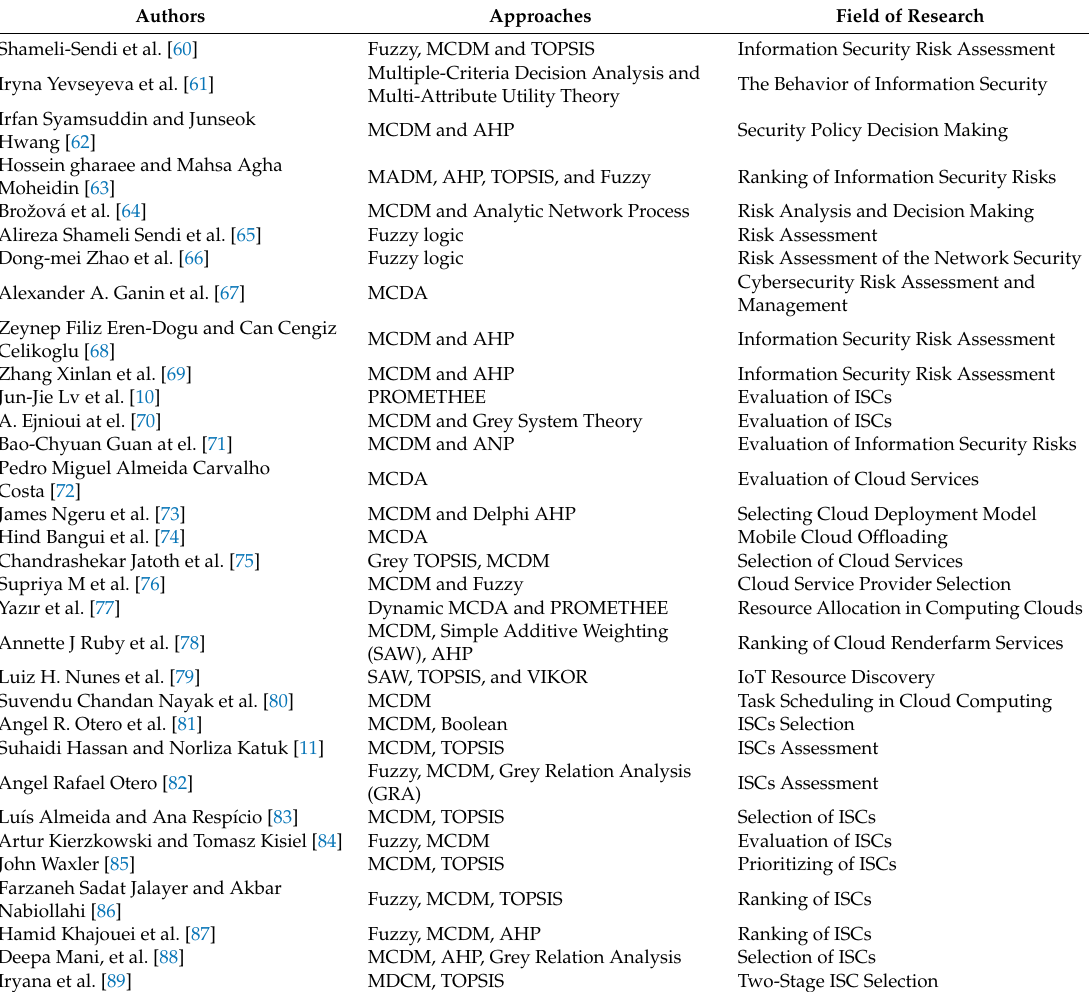
Table 1. Related research for information security risk and control